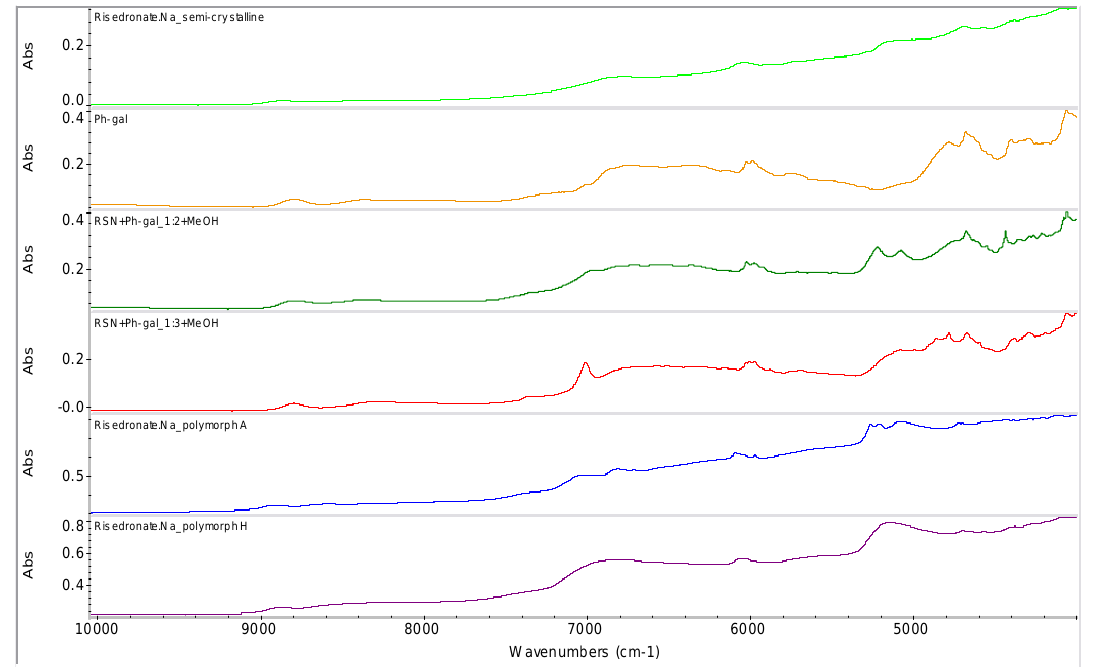
Figure 12. NIR spectra of semi-crystalline risedronate mono-sodium salt (RSN), forms A and H and phenyl- β - D -galactopyranoside (Ph-gal) and spectra of mixtures of RSN+Ph-gal in ratios 1:2 and 1:3 prepared by addition of MeOH and evaporation of liquid part at ambient temperature (samples 6 , 7